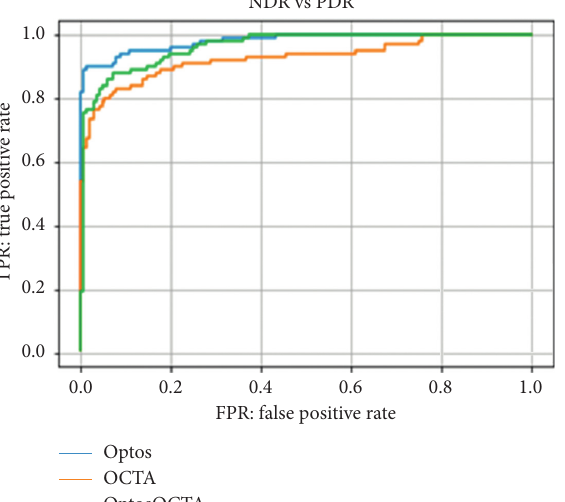
Figure 6: Receiver-operating characteristic curve for test 2 (no apparent diabetic retinopathy [NDR] vs. proliferative diabetic retinopathy [PDR]) for Optos, optical coherence tomography angiography (OCTA), and Optos OCTA images. The order of imaging methods used based on the accuracy of their results was as follows: Optos, Optos OCTA, and